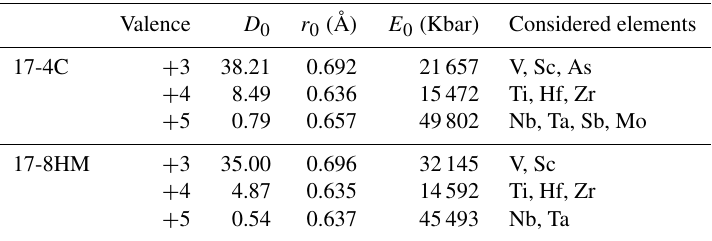
Table 6. Lattice parameters calculated from partition coefficient data for the M (1-3) site in amphibole for experiments with comparable SiO 2 but different f O 2